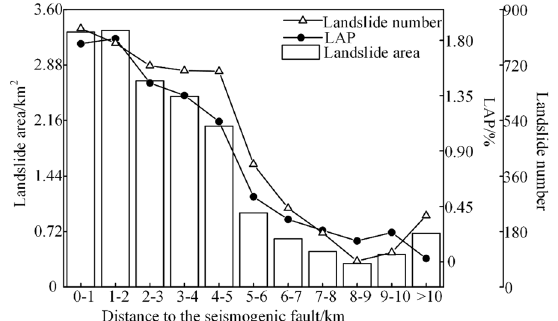
Fig. 7 Analysis diagram for landslide evaluation index and distance to seismogenic